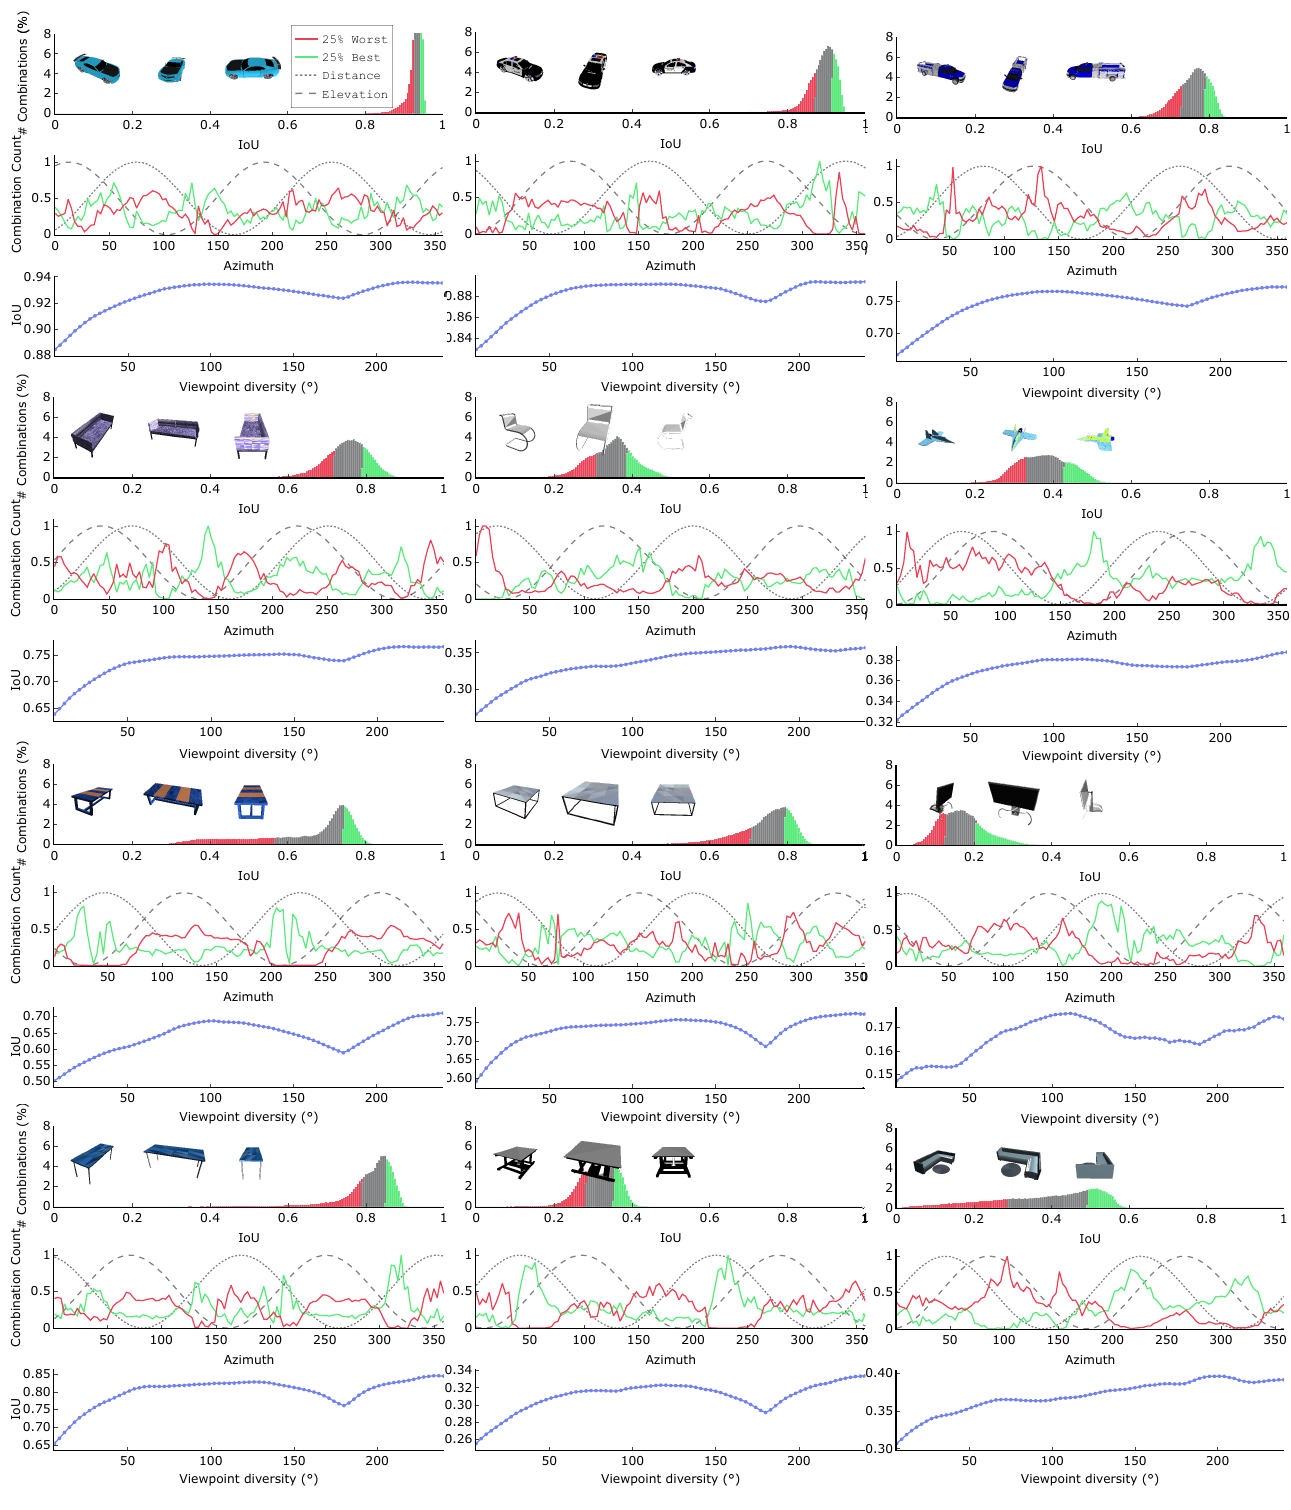
Figure A3. Same explanation as in Figure 8 in Section